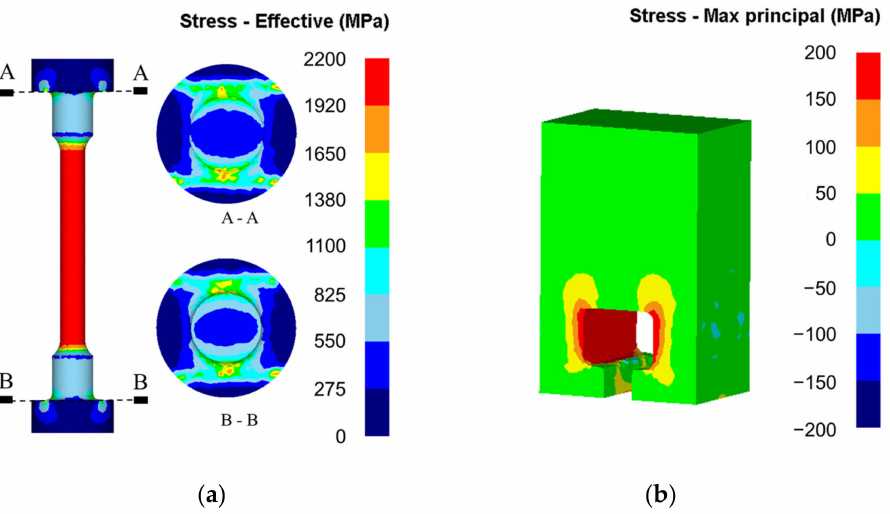
Figure 5. Result of jig analysis of conventional method: ( a ) effective stress of specimen and ( b ) maxi- mum principal stress of